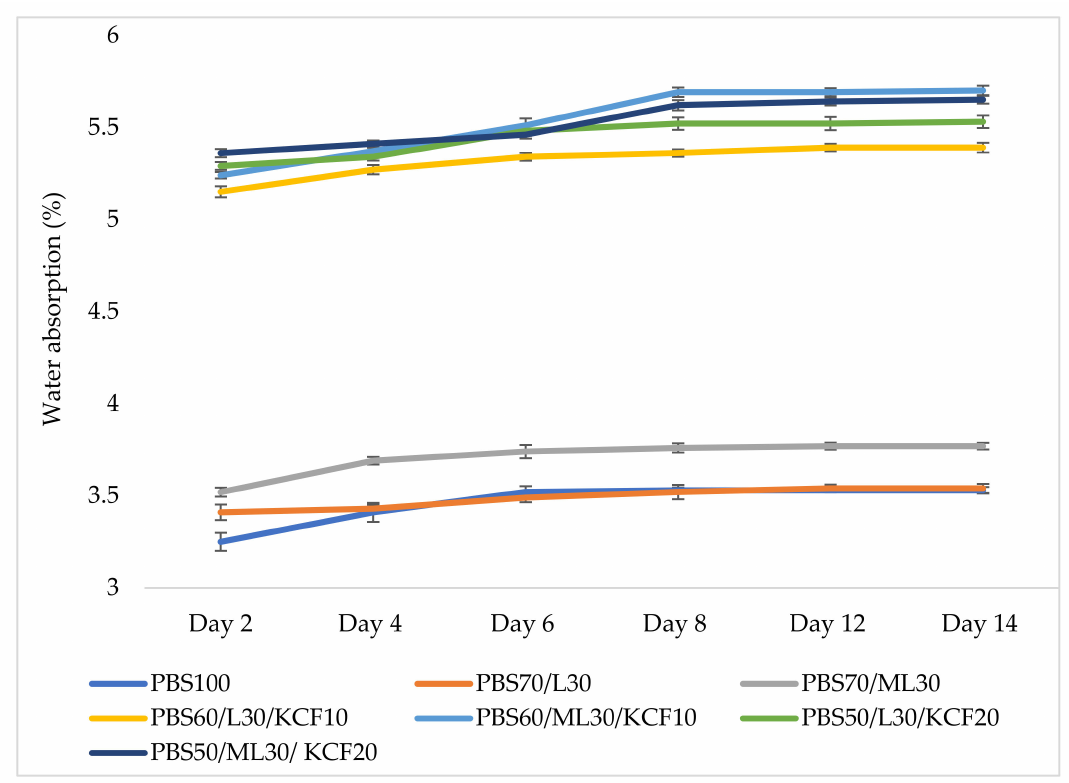
Figure 6. Water absorption of PBS and its composites. Note: Poly (butylene succinate) (PBS), Lignin (L), Modified Lignin (ML), Kenaf Core Fiber